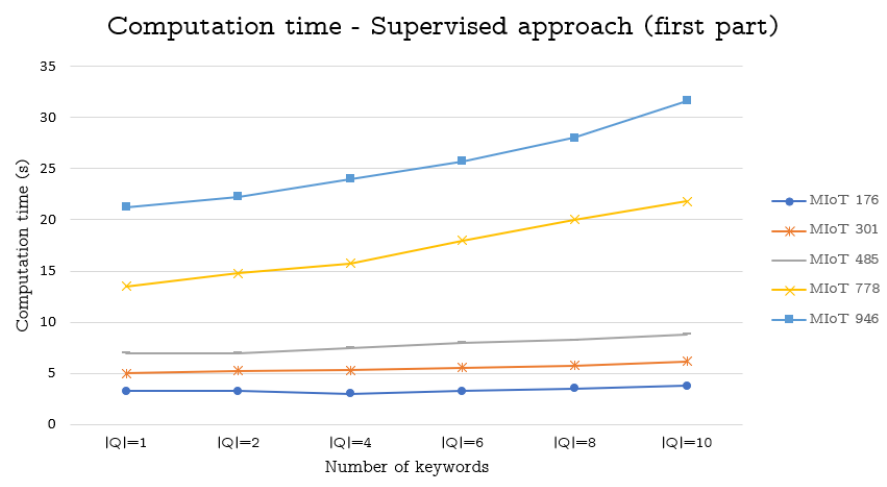
Figure 1. Computation time (in seconds) against the size of MIoTs and queries used to generate the virtual IoTs (supervised approach)—first part.